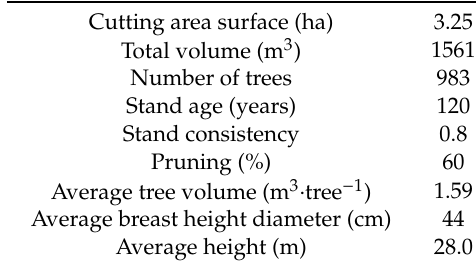
Table 1. Characteristics of felled trees and tree